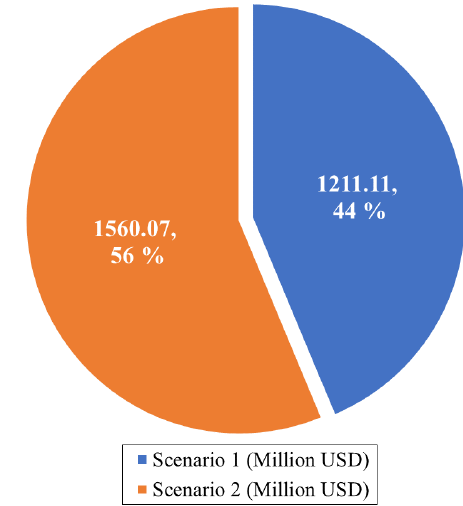
Figure 11. Indirect